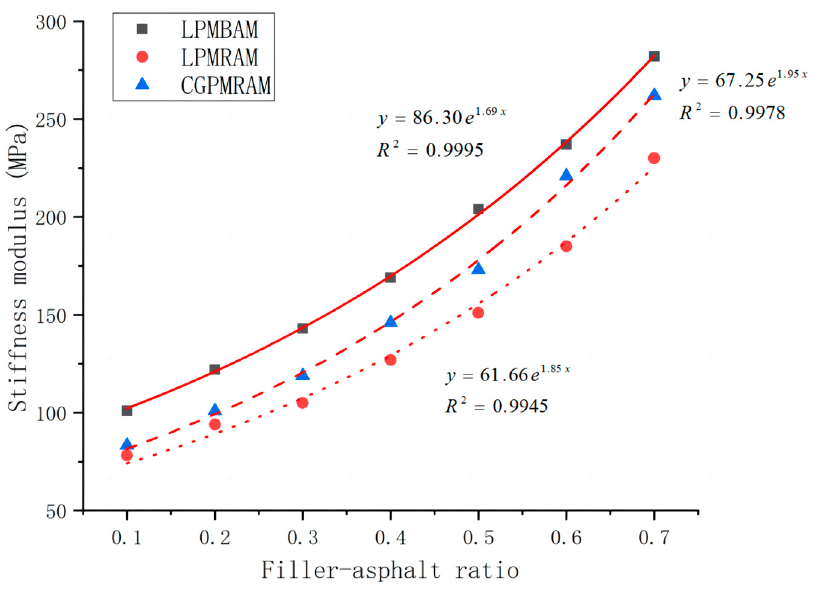
Figure 8. Low-temperature ( − 12 ◦ C) performance fitting curves of the mortar.